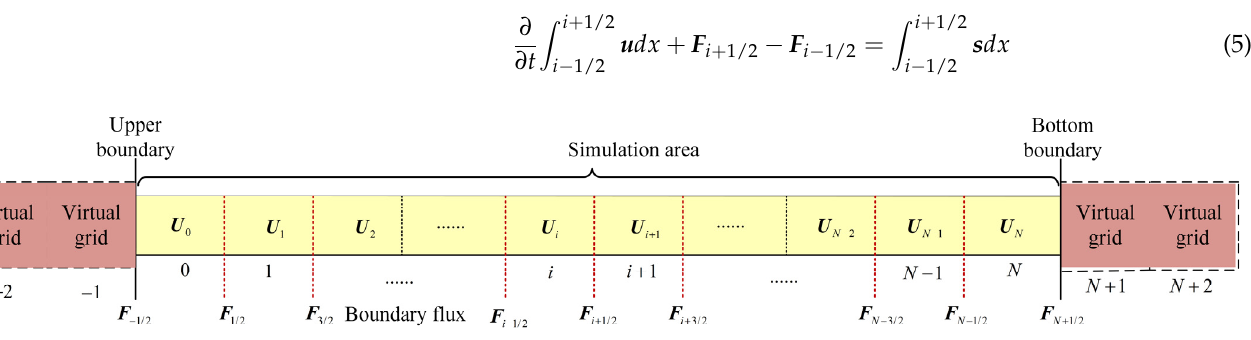
Figure 1. Schematic diagram of pipeline meshing.